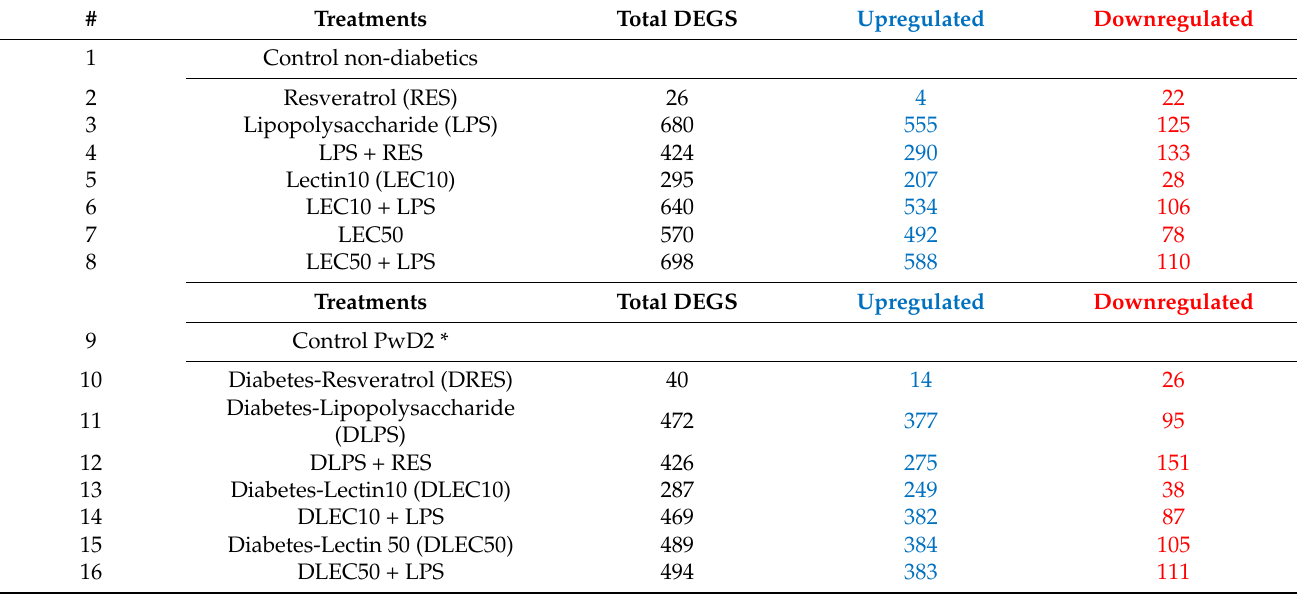
* PwD2 = People with type 2 diabetes. DEGS = Differentially expressed genes. Blue color is used for gene expression for PBMCs from non-diabetic subjects and red color is used for PBMCs from PwD2 treated with different